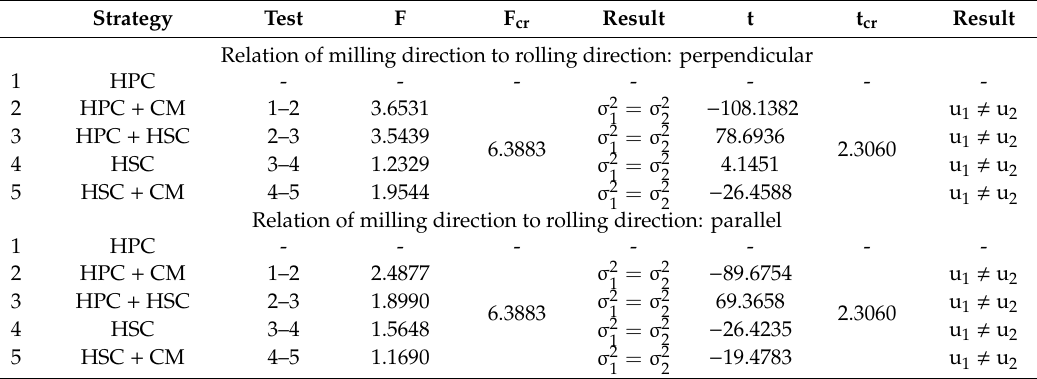
Table 7. Statistical verification of the results of relative deformations ε ( α = 0.05)—with textured surface layer removal (CM).